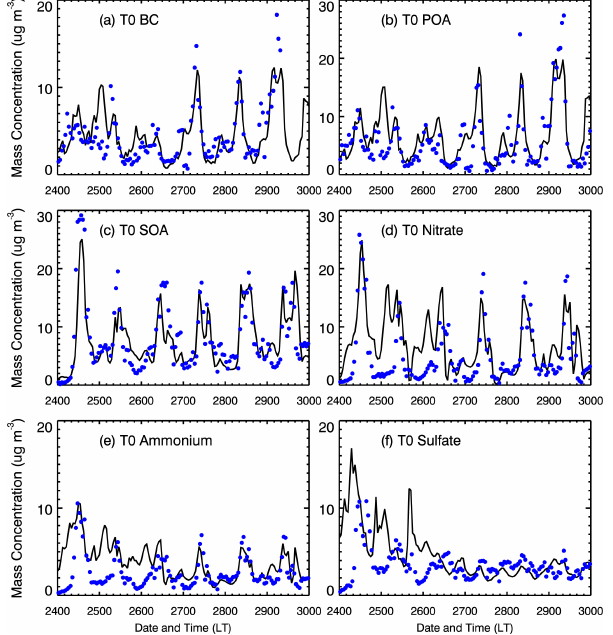
Fig. 2. Diurnal variations of measured (blue dots) and simulated (black line) aerosol concentrations at T0 during the period from 24 to 29 March, 2006. The x-axis labels (named date and time) repre- sent day and hour (DDHH). For example, 2400 represents 00 local time on 24